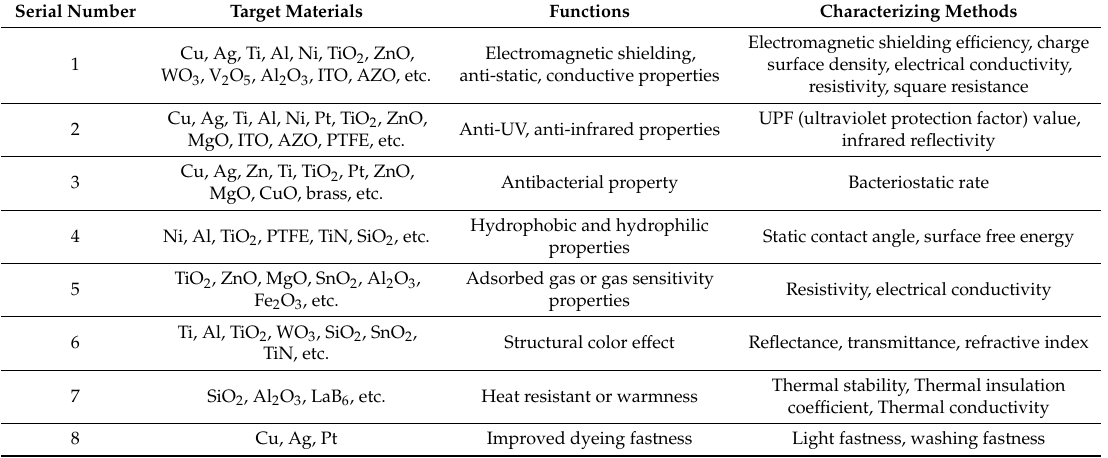
Table 1. Common target materials and functions and characterizing methods of magnetron sputtering coated